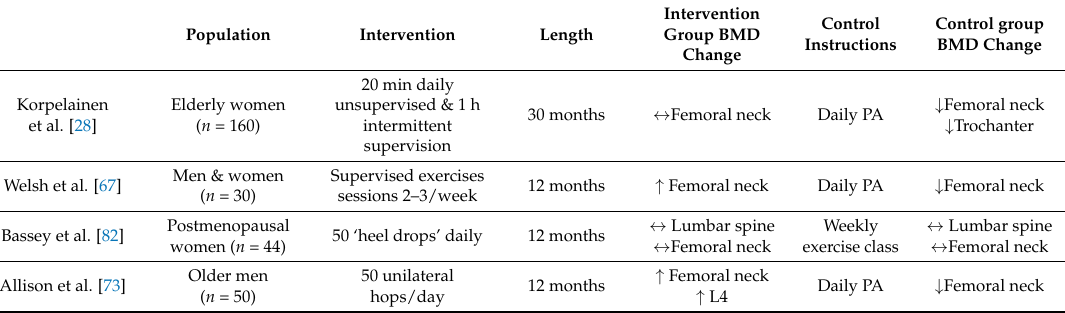
Table 1. Summary table highlighting differences in selected studies examining the effect of high-impact exercise on bone mineral density in randomised control